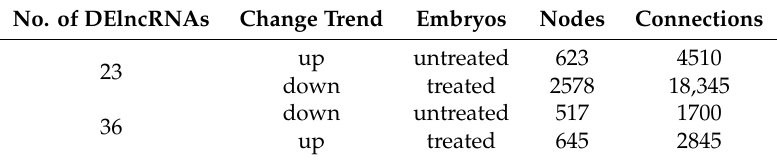
Abbreviations: DElncRNAs, di ff erentially expressed